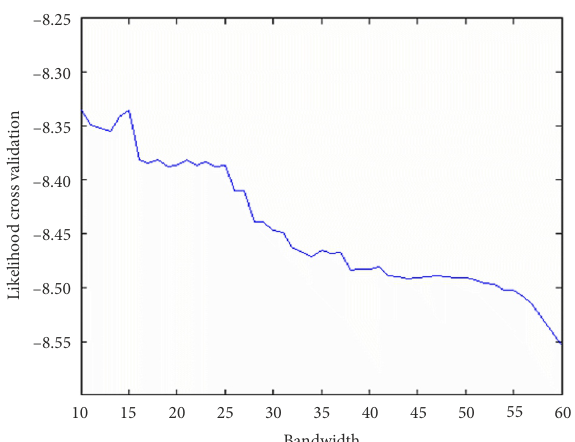
Figure 2. Determination of bandwidth when using Z-order- m